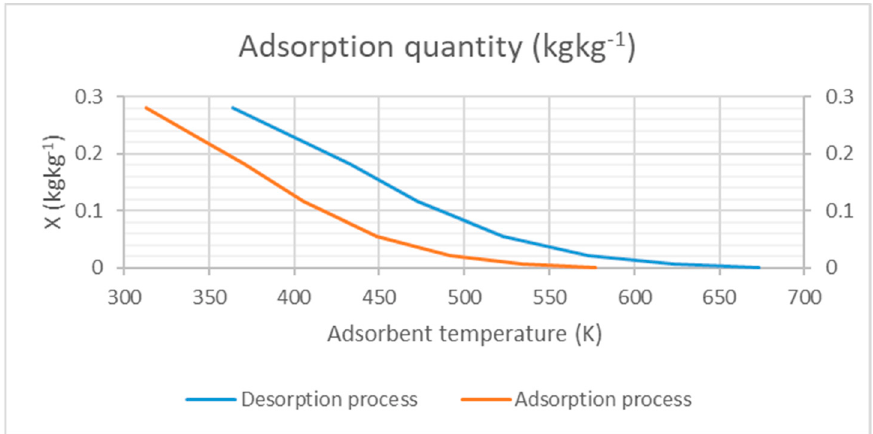
Figure 4. Quantity of adsorption versus adsorbent temperature.